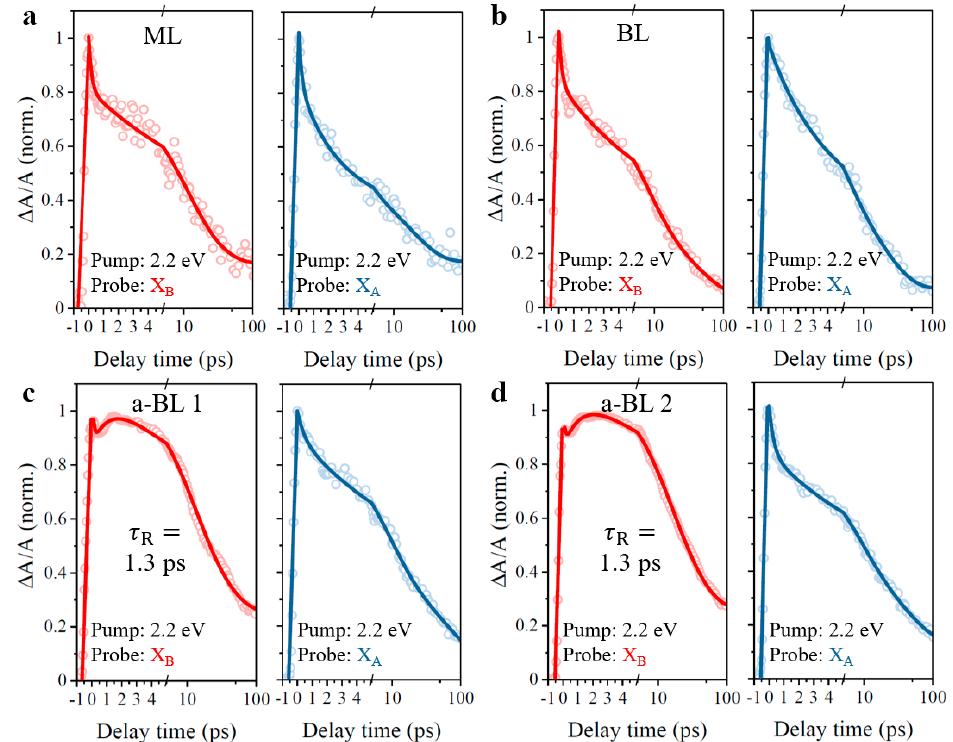
Figure 10. Pump-probe dynamics with off-resonant 2.2 eV excitation. ( a ) ML, monolayer MoS 2 . ( b ) BL, normal bilayer. ( c ) a-BL 1, anomalous bilayer 1. ( d ) a-BL 2, anomalous bilayer 2. Samples from ( a ) to ( d ) are in accordance with region 3, region 4, region 1, and region 2 in Figure 7. X B , B-exciton resonance; X A , A-exciton